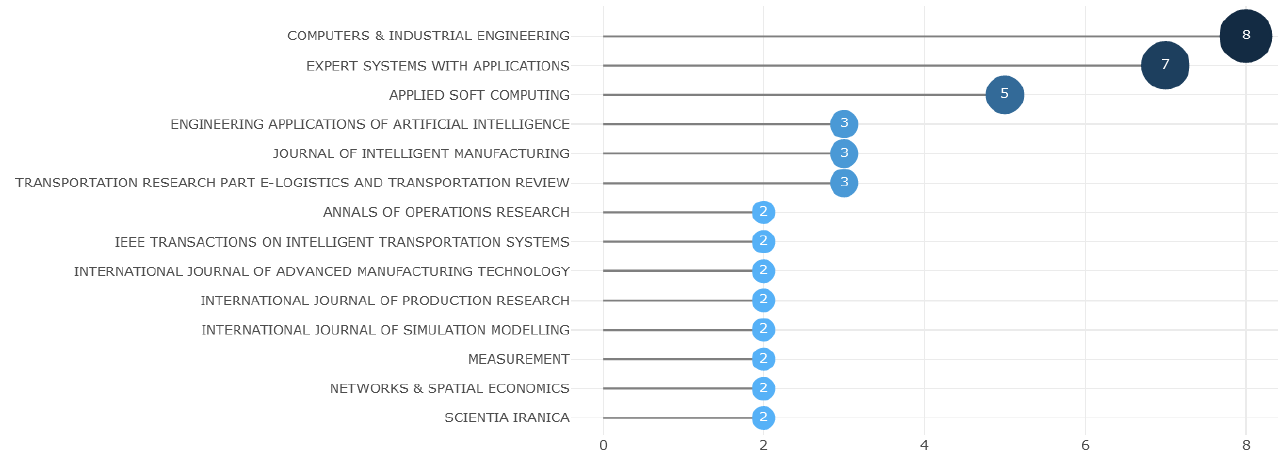
Figure 3. Most cited institutions for Web of Science PSO/VRP publications, h-index score.